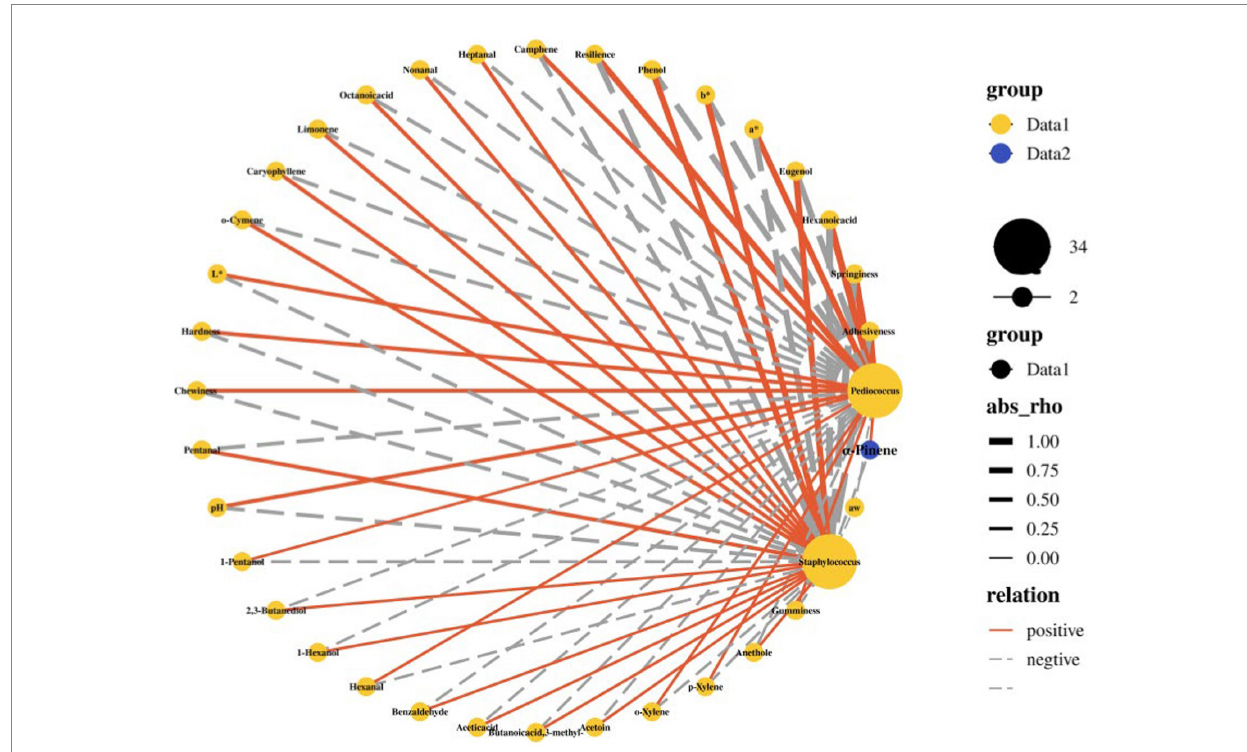
FIGURE 4 Pearson correlation analysis between bacterial community and various indexes in fermented sausage at 8 days. The edge width is proportional to the correlation strength. The solid line represents a positive correlation between the two indicators, while the dotted line represents a negative correlation between the two